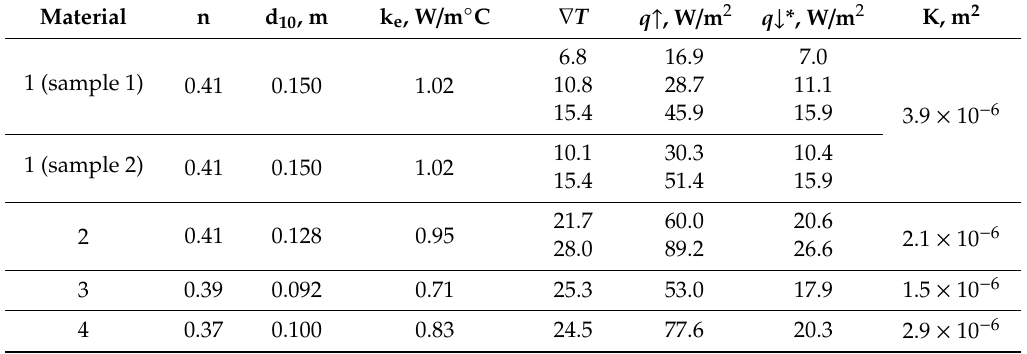
Table3. Samplecharacteristics, experimentalresultsandback-calculatedvaluesofintrinsicpermeability.